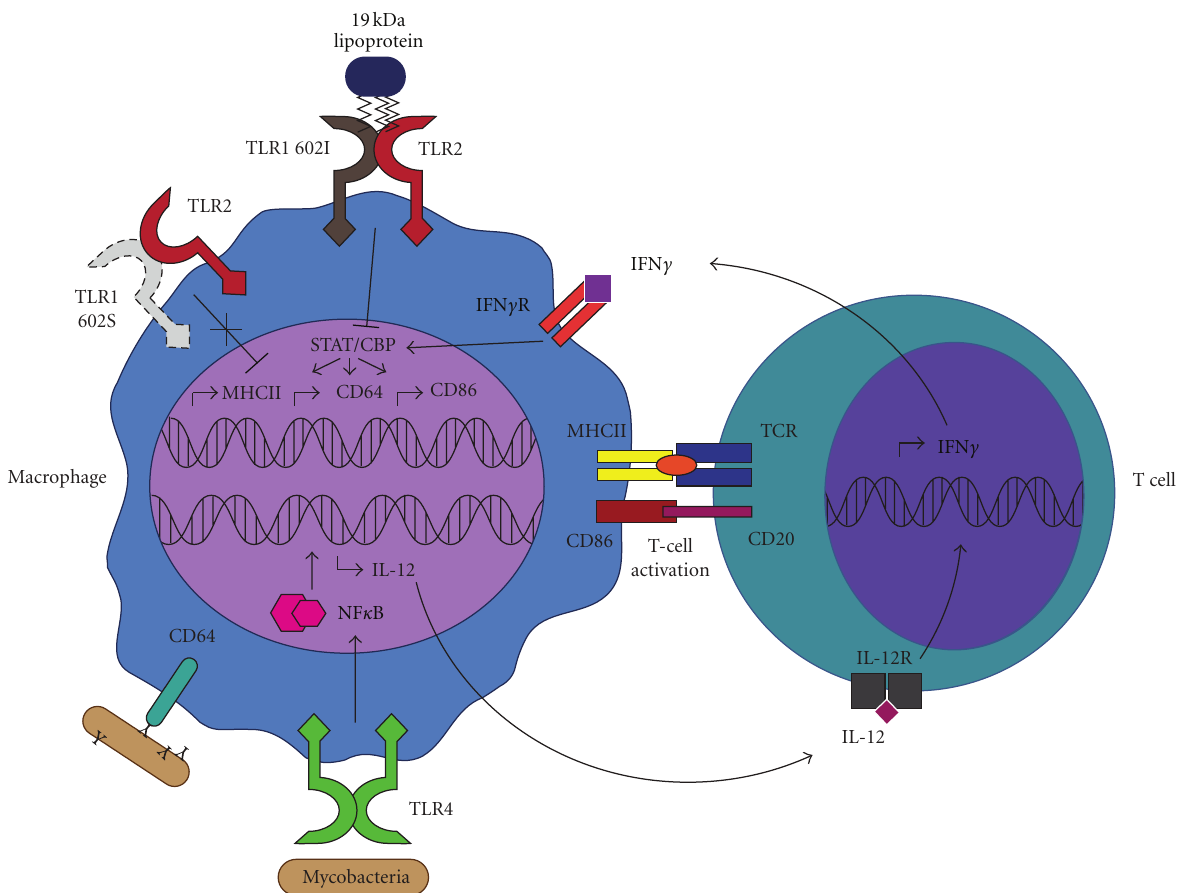
Figure 1: Stimulation of macrophage TLRs by bacterial products activates NF κ B which drives transcription of interleukin-12, along with other cytokines and chemokines that subsequently recruit and instruct T cells. Secreted IL-12 stimulates T cells to produce IFN γ , which serves to further stimulate the macrophage. Activation of macrophages by IFN γ leads to induction of transcription factors such as STAT1 and CBP, which facilitate production of transactivators, including CIITA. This results in the transcription of multiple IFN γ -regulated genes, including MHCII, CD86, and CD64. MHCII is required for antigen presentation and, along with CD86, is used by macrophages to activate CD4 + T-helper cells. Antibody-opsonized particles are recognized by the phagocytic receptor, CD64, which binds the Fc portion of IgG. TLR1 602I tra ffi cs to the cell surface where it forms heterodimers with TLR2 to sense microbial agonists. Binding of the mycobacterial 19kDa lipoprotein to TLR1/2 has been shown to block STAT1-CBP activity, thereby dampening the induction of IFN γ -regulated genes. It is possible that the tra ffi cking-deficient TLR1 602S allele (dashed lines) confers protection against leprosy and TB by preventing the subversion of IFN γ signaling by these mycobacterial